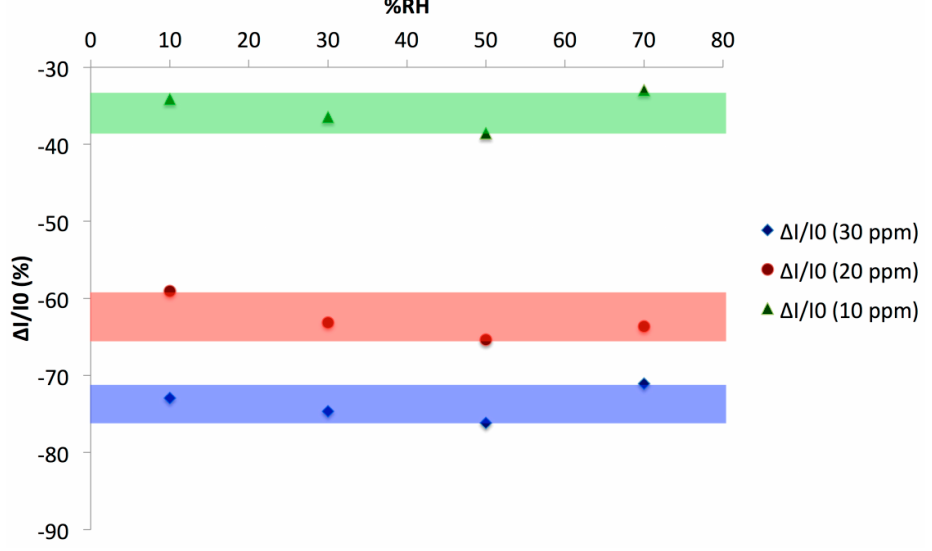
Figure 15. Relative response (ΔI/I function of the Relative Humidity, as calculated from four 0.25/1 min exposure/recovery cycles. From bottom to top, the NH blue bands show the range of the relative response for respectively 10, 20 and 30 ppm NH